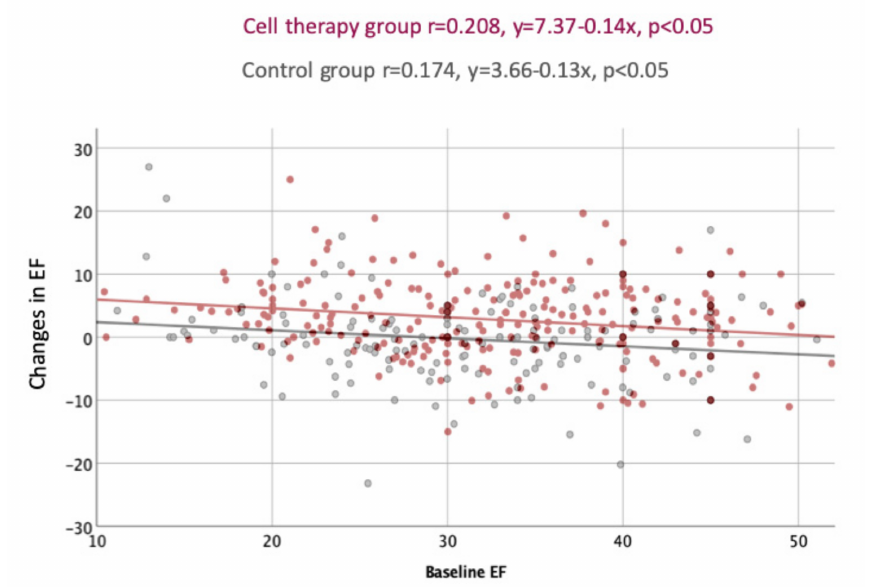
Figure 4. Association between baseline EF and changes in EF including only the IPD of the ACCRUE studies ( n =